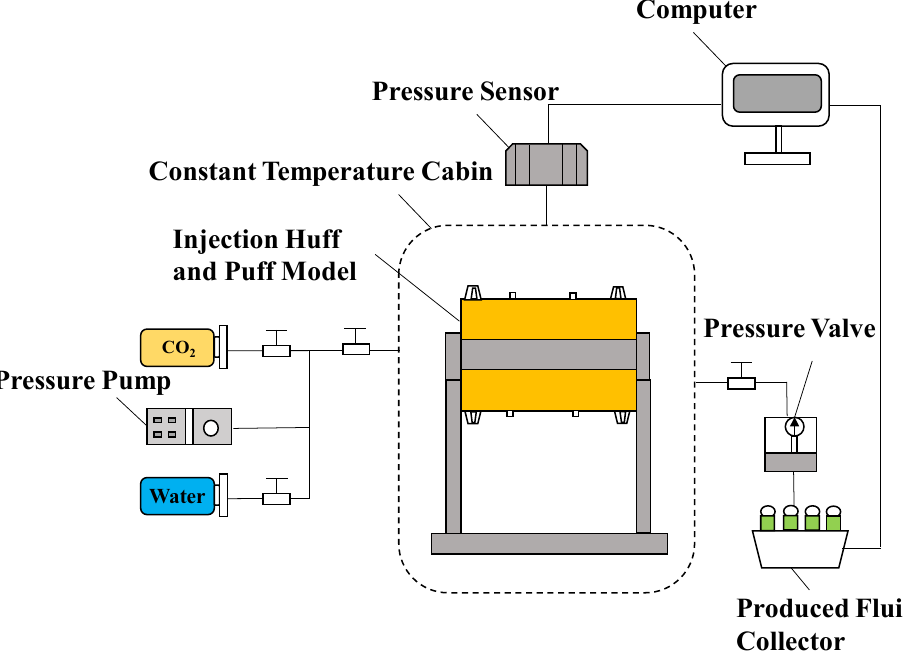
Figure 2. Three-dimensional physical simulation system for huff and puff.